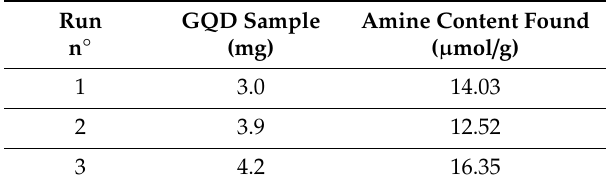
Table 1. Amine content found in Kaiser test of graphene quantum dots formed from oxacillin and ethylenediamine (EDA) precursors (e-GQDs) in